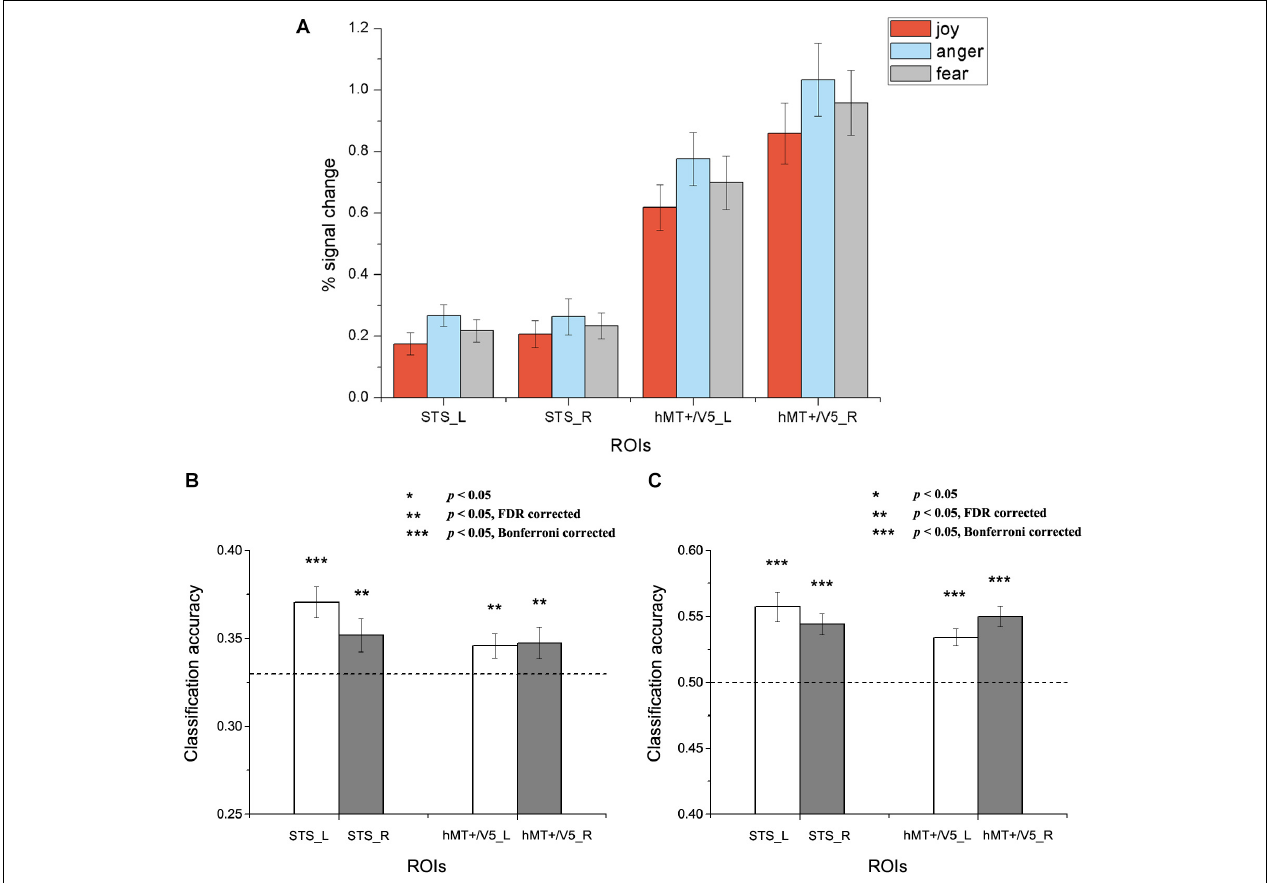
FIGURE 4 | Results of the within-subject emotion decoding analysis. (A) Average percent signal change for each emotion, (B) Classification accuracies for three emotions, and (C) Classification accuracies for positive versus negative emotions. The dashed line indicates chance level, and all error bars represent the standard error of the mean (SEM). Asterisks indicate statistical significance with a one-sample t -test, p < 0.05 [** p < 0.05 false discovery rate (FDR) corrected; *** p < 0.05 Bonferroni corrected].